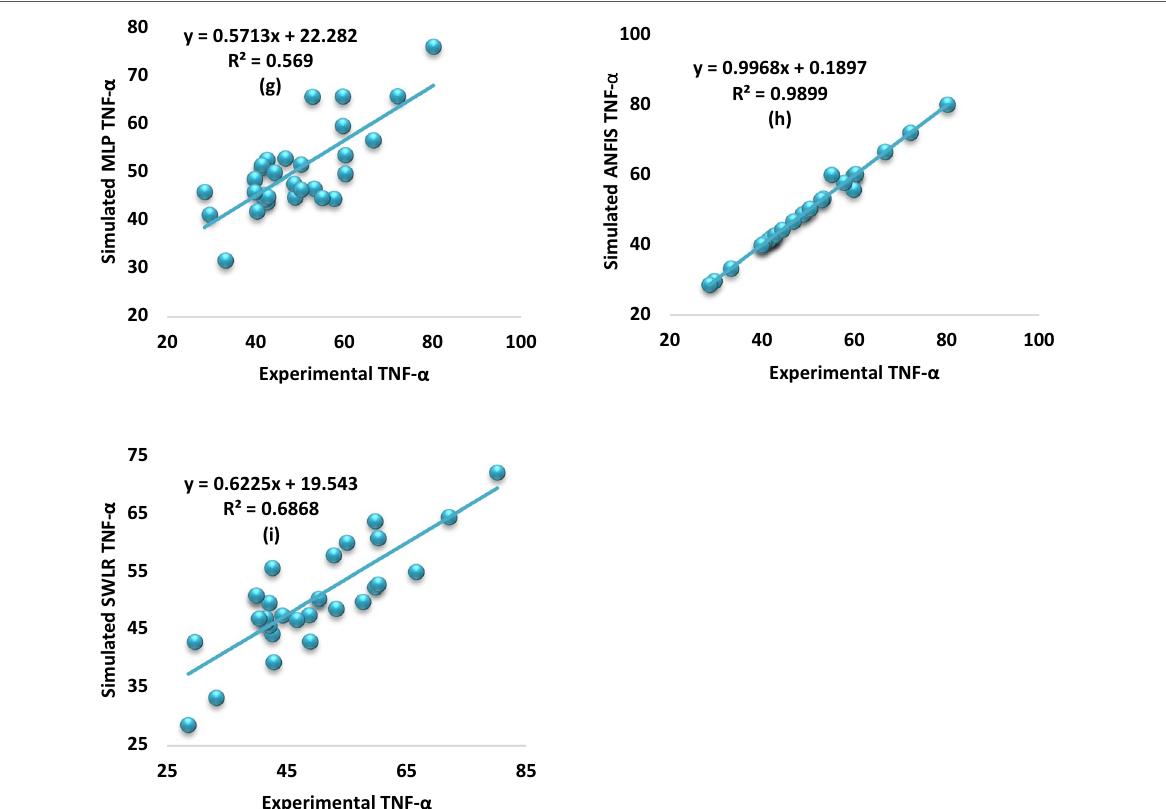
The best performing model are written in bold